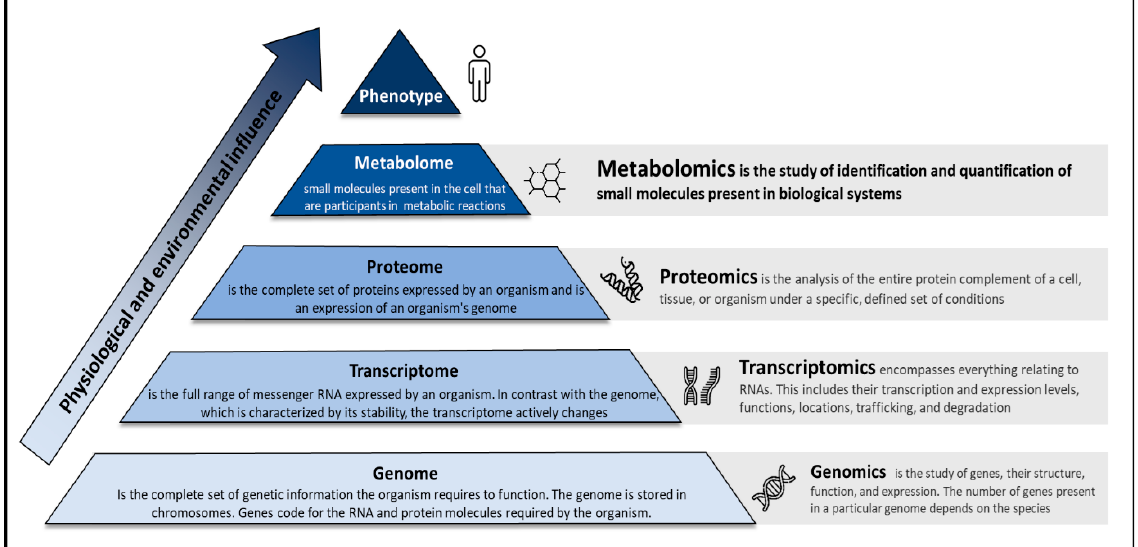
Figure 2. The pyramid of life and the omics sciences.